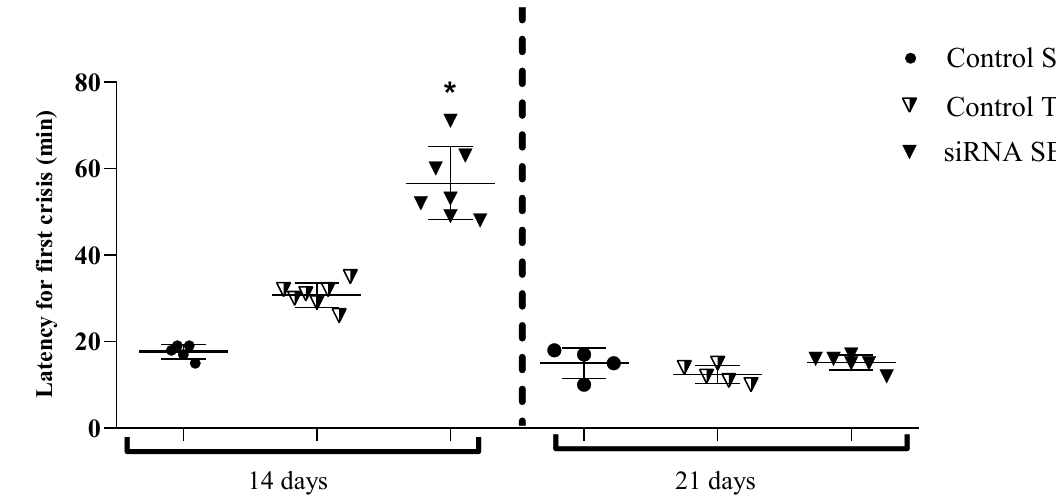
Figure 4. Latency for first tonic–clonic seizures in animals submitted to SE in a pilocarpine-induced epilepsy model. The bars represent the mean ± standard deviation. * p < 0.05 compared to the 14-day control SE group, p < 0.05 compared to the 21-day control SE group. Groups 14 days and 21 days were individually analyzed by the one-way ANOVA test and Shapiro–Wilk. Animal groups were divided as follows: CONTROL SE (no intranasal treatment/SE induction after 14 days of group formation); CONTROL TRANSFECTION SYSTEM SE (intranasal treatment with transfection system/SE induction after 14 days of intranasal treatment) and siRNA SE: (intranasal treatment with siRNA/SE induction after 14 days of intranasal treatment). Only for analysis of antiepileptic performance experiments and for a better exploration of results, an additional animal group was SE-induced 21 days after the group arrangement (CONTROL SE) or intranasal treatments (CONTROL TRANSFECTION SYSTEM SE and siRNA SE groups) and was evaluated separately from the other animal groups in which SE was induced after 14 days of their treatment/formation.